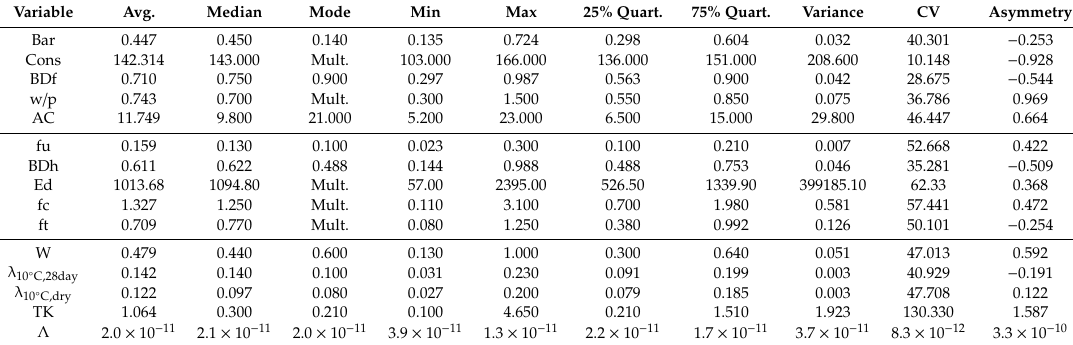
Note to Table 5: CV—Coe ffi cient of Variation; Mult.—multiple